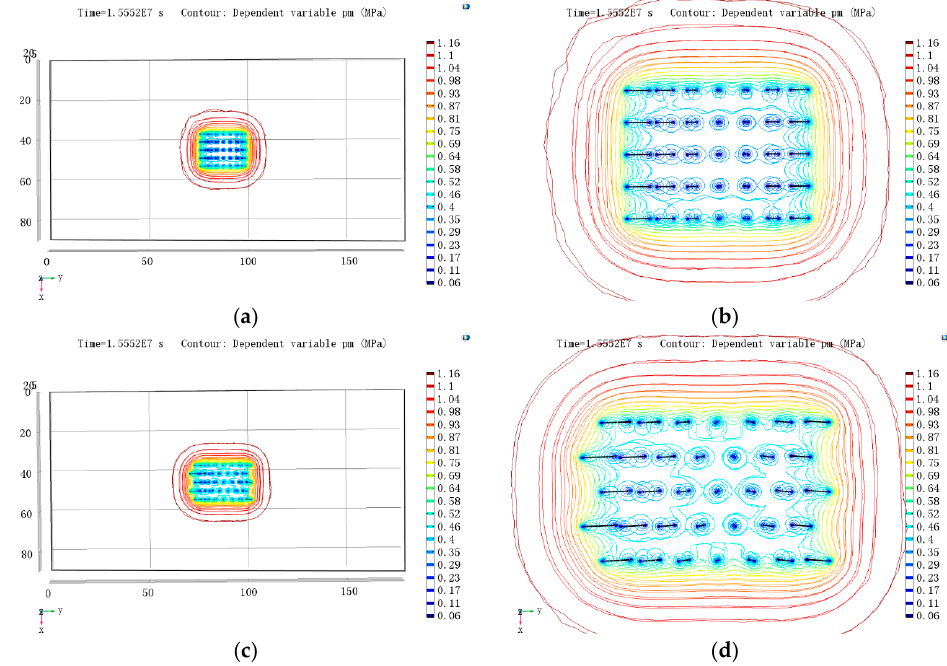
Figure 12. Isobaric lines of gas pressure before and after optimization. Isobaric lines of gas pressure on the inclined plane of borehole bottom (rectangular configuration, at a spacing of 4 m): ( a ) overall map, ( b ) enlarged view. Isobaric lines of gas pressure on the inclined plane of borehole bottom (rhomboidal configuration, at a spacing of 5 m): ( c ) overall map, ( d ) enlarged view.